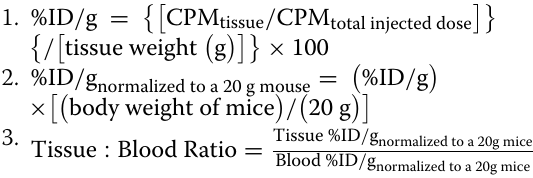
group shows the expected local ×